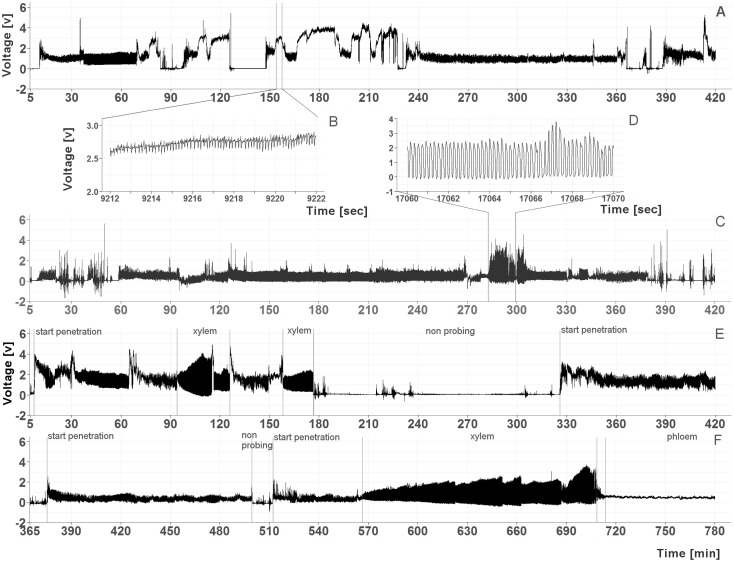
(A–D) Examples of EPG recordings from C. pruni nymphs (5th instar) on spruce (A) with a detailed magnification of phloem phase waveform (B) and on fir (C) with a detailed magnification of the waveform of xylem feeding (D). (E,F) Examples of recordings from a female C. pruni emigrant on larch (E) and a male emigrant on fir (F) with marked penetration and feeding phases.